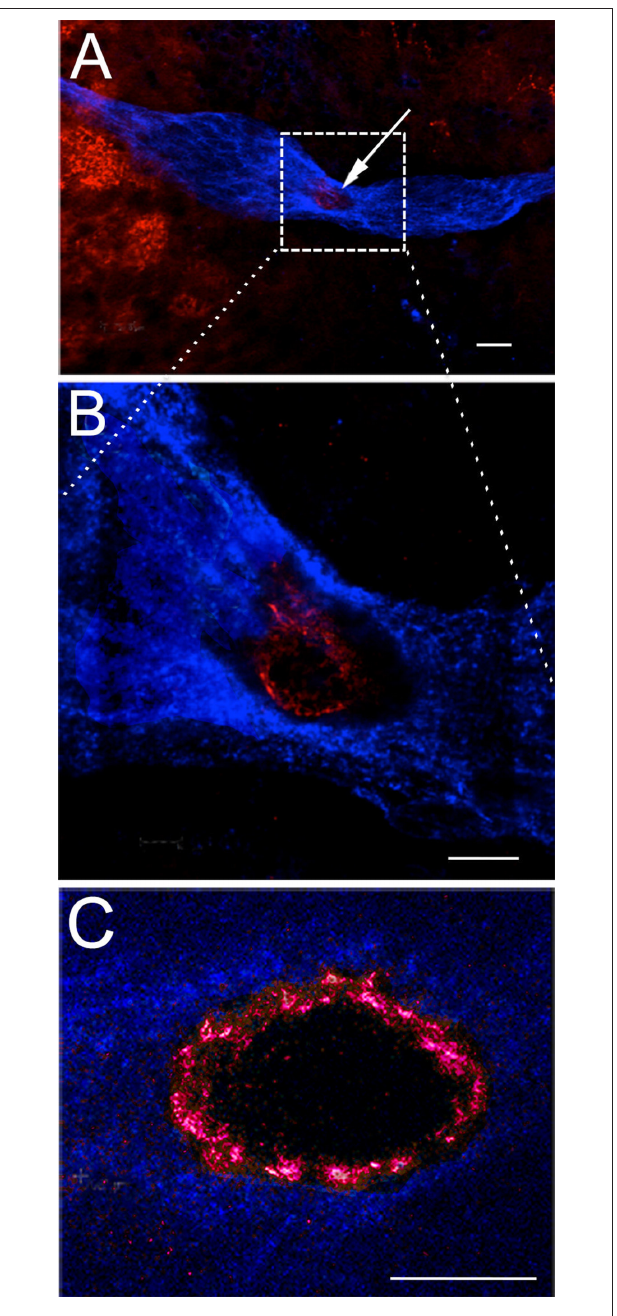
FIGURE 8 | Serotonin is localized in the rim of the vascular cavity . The neurogenic niche in P. clarkii , labeled immunocytochemically for glutamine synthetase (blue) and serotonin (red). The vascular cavity is outlined by a rim of serotonin labeling, most clearly seen in (C) . The additional serotonin labeling observed in (A) to the left of the niche is localized in neural terminals in the accessory lobe. (A,B) were contributed by V. Quinan. Scale bars: (A) , 20 µ m; (B) , 10 µ m; (C) , 10 µ m.